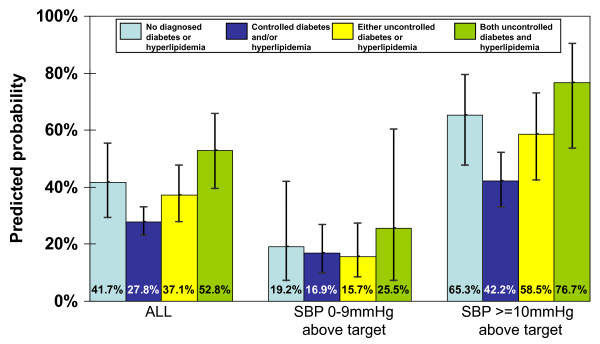
Predicted probabilities of blood pressure medication intensification by clinical scenario among uncontrolled hypertensive patients. Error bars represent 95% confidence intervals.